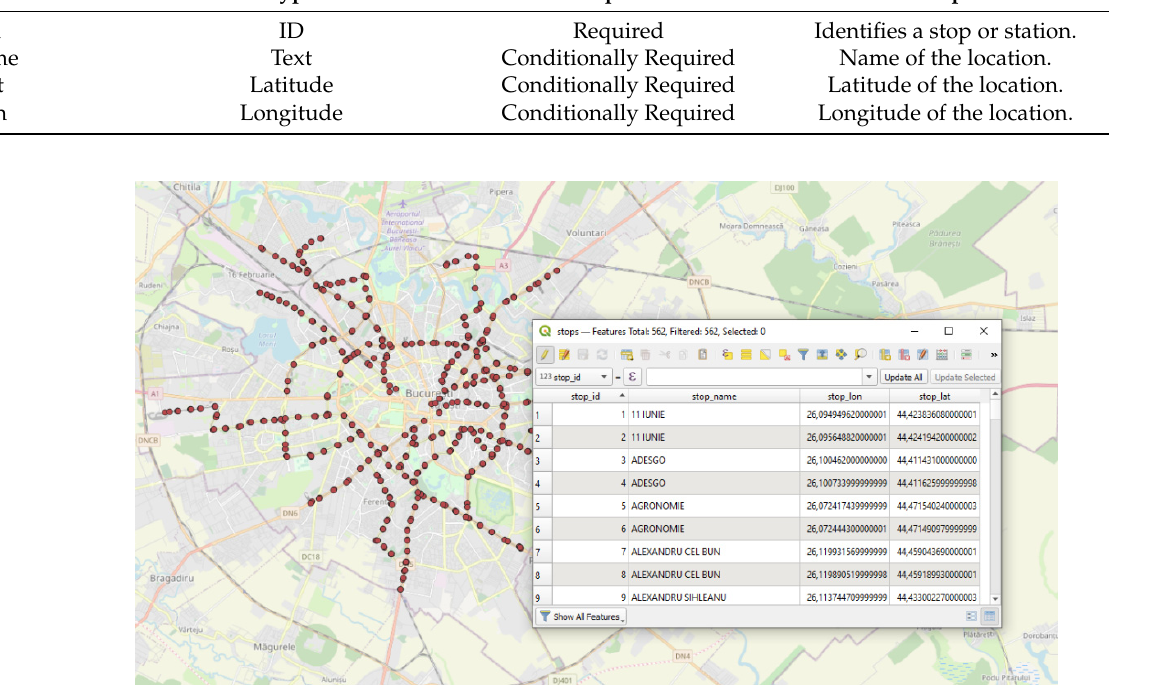
Figure 3. Tram station georeferencing (station positions are represented by dots on the map, and the attributes table contains their IDs, names, and geographical positions) (© OpenStreetMap con- tributors).